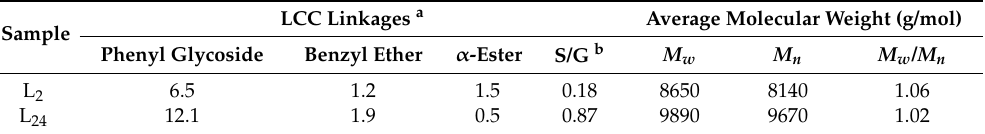
Table 5. Quantification of LCC linkages (%, based on 100 Ar) and average molecular weight of the L 2 and L 24